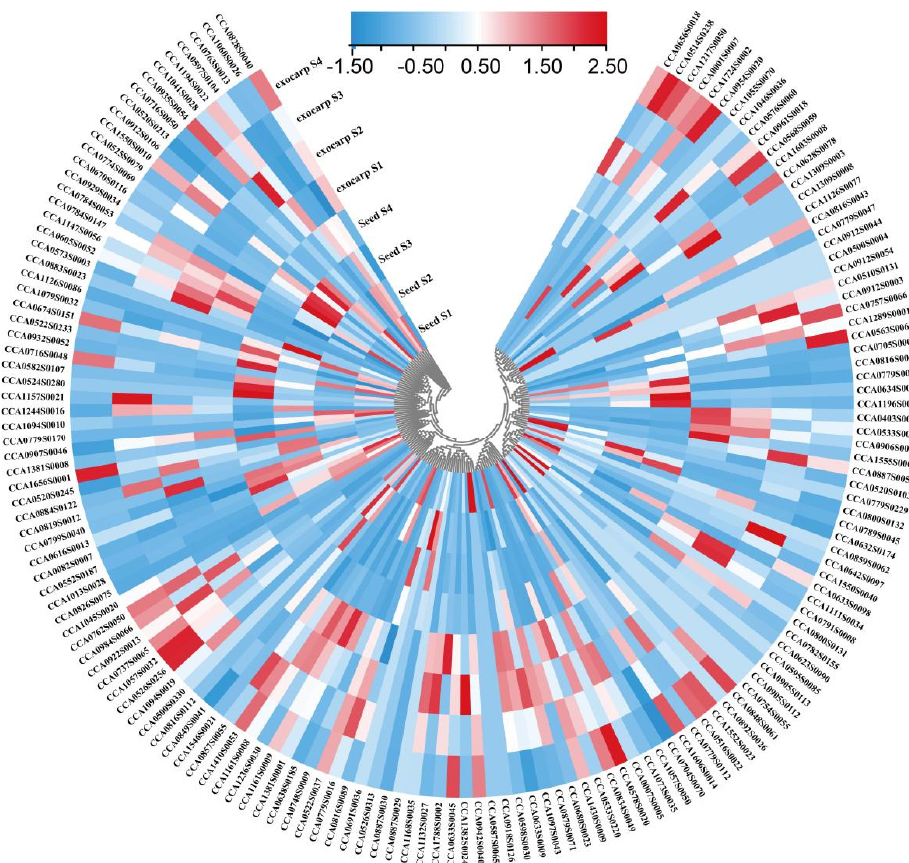
Figure 3. Expression pattern analysis of all R2R3 − MYB family genes during hickory exocarp and seed development. A hierarchical clustering heatmap was plotted based on FPKM via log2 transformation. Color bars indicate range of log2 (FPKM).